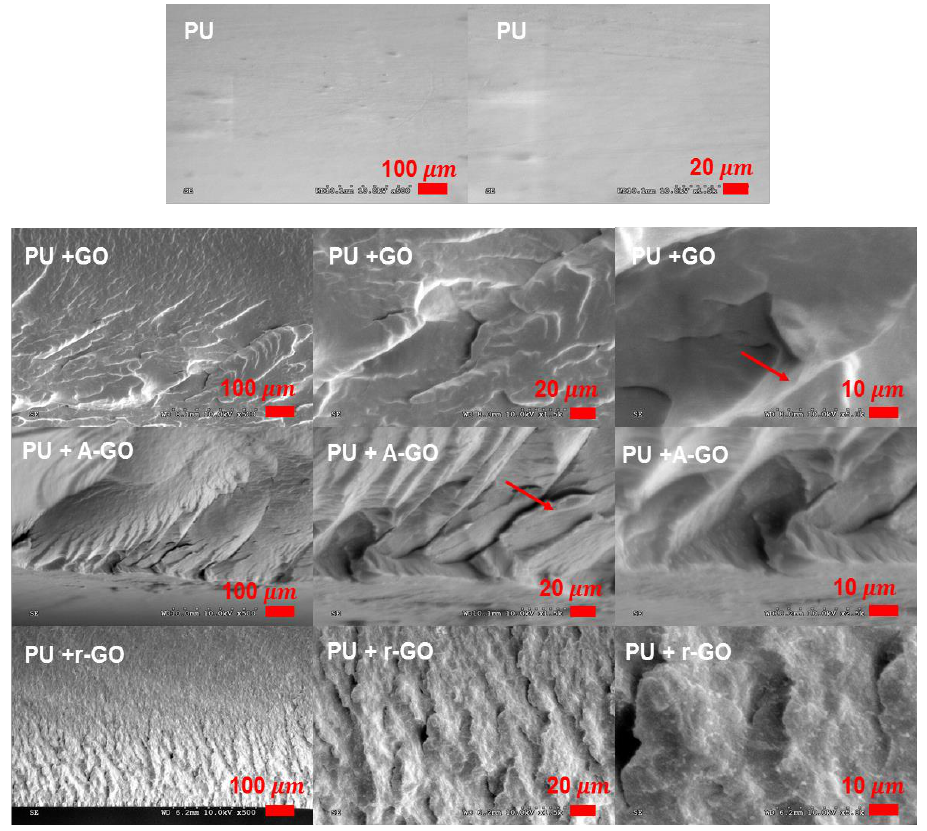
Figure 17. SEM micrographs of the fractured surfaces of the PUs. Red arrows show the location of the GO derivative sheets.